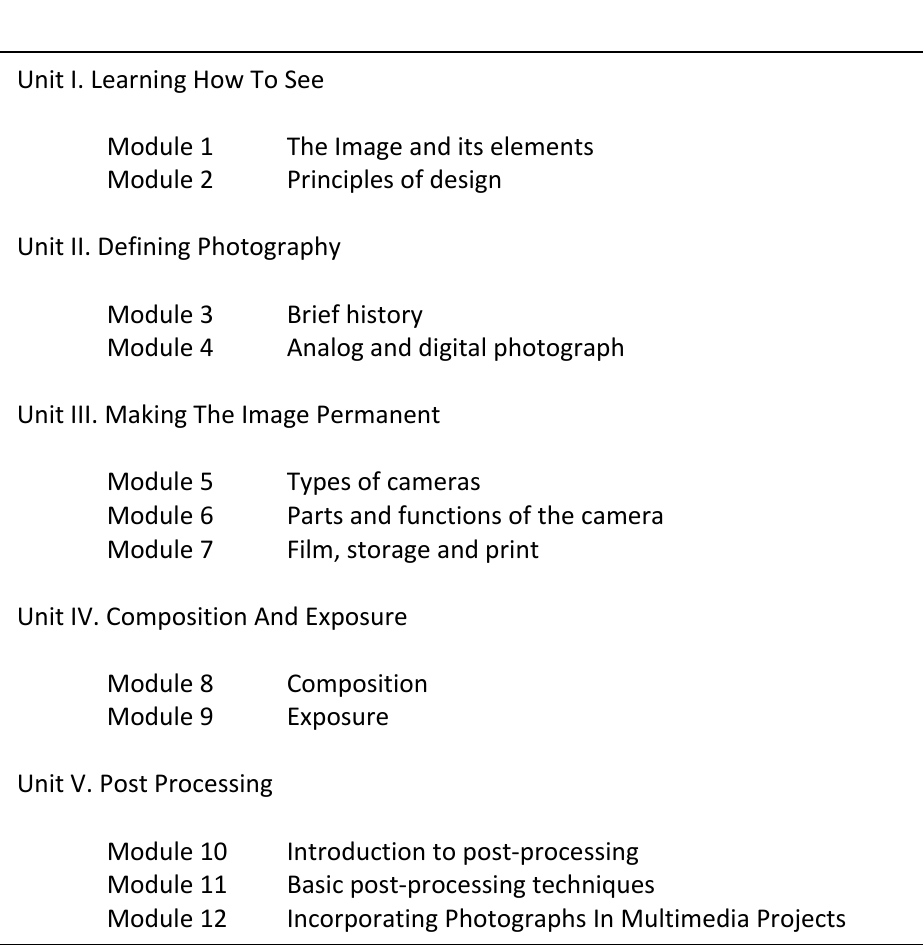
Figure 1. Multimedia studies 173 course